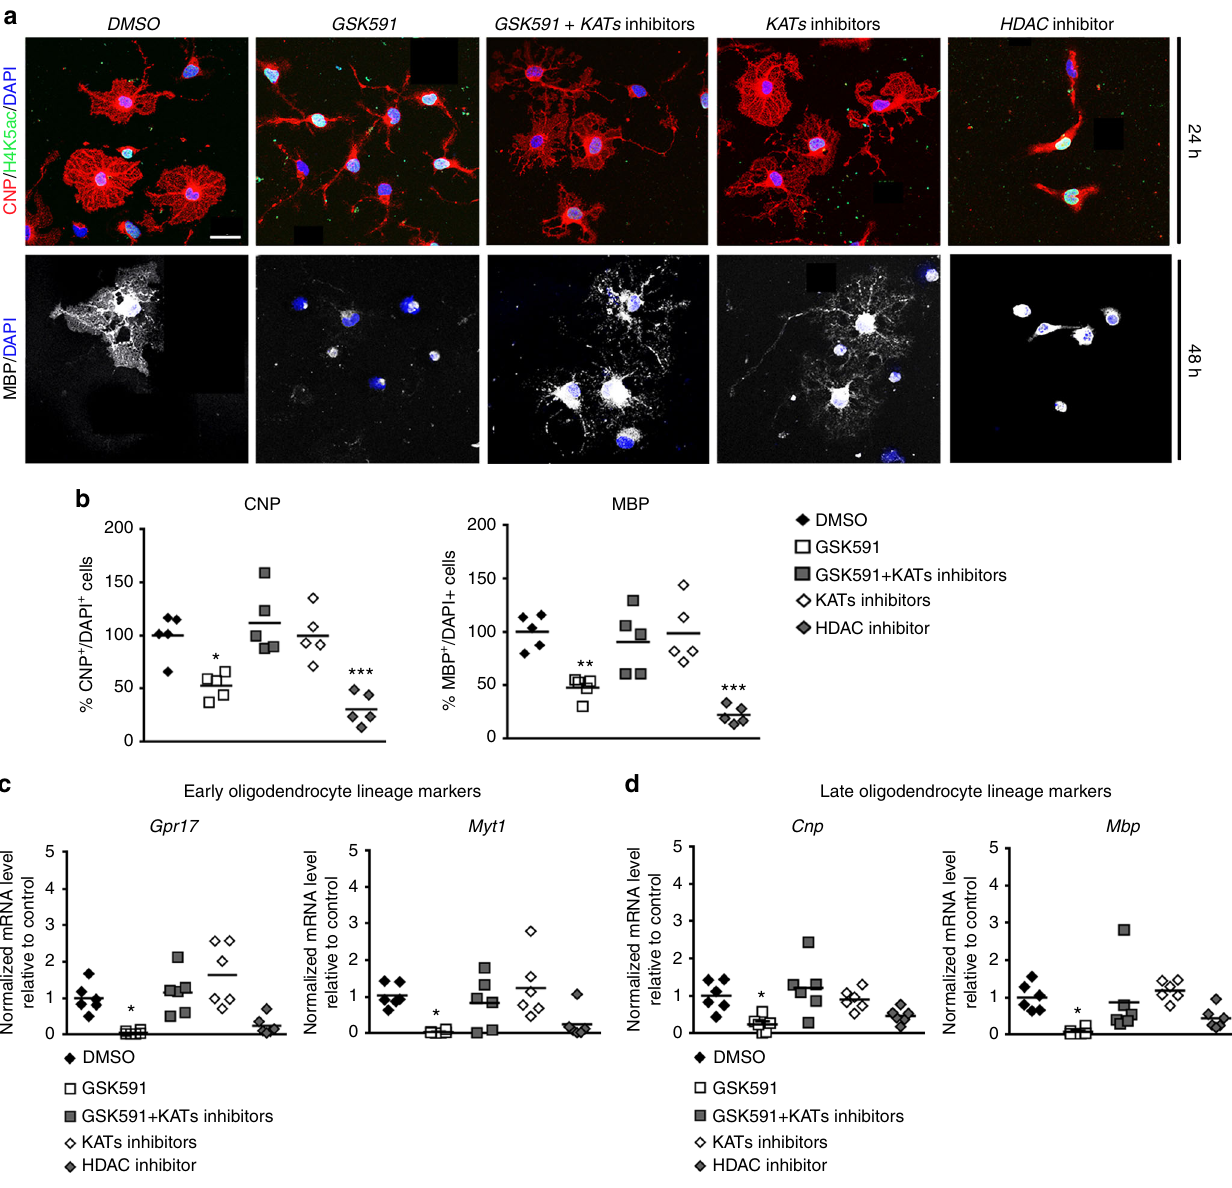
Fig. 8 Inhibitors of histone acetyltransferases rescue the effect of PRMT5 loss of activity. a Representative confocal images of OPCs cultured in differentiating conditions for 24 and 48 h with DMSO, GSK591, GSK591 + KAT inhibitors, KAT inhibitors (Butyrolactone-3, 100 μ M and NU-9056, 0.2 μ M) alone, and with the HDAC inhibitor Trichostatin A (TSA, 20 nM). Cells were then stained for CNP (red), MBP (white), H4K5ac (green), and DAPI (blue) (scale bar: 10 μ m). b Scatter plots of the average number of CNP + (24 h, upper panel) and MBP + (48 h, lower panel) cell relative to total DAPI + cells counted in fi ve wells from three biological replicates. An average number of 367 cells was counted per condition and referred as percentage of the values in the DMSO treated cells. One-way ANOVA with multiple comparison test, * p < 0.05, ** p < 0.01, and *** p < 0.001. c , d qRT-PCR of ( c ) early ( Gpr17 , Myt1 ) and ( d ) late ( Cnp , Mbp ) oligodendrocyte lineage gene transcripts measured in six independent preparations and normalized to the geo-mean of three housekeeping genes ( 18s , Wdr33 , and Pja2 ) and to the internal control (DMSO) at 48 h after treatment. Values were referred to those of the internal control samples (DMSO). One-way ANOVA with Bonferroni multiple comparison test performed for each gene relative to control (* p < 0.05, ** p < 0.01, and *** p < 0.001). n = 6 independent